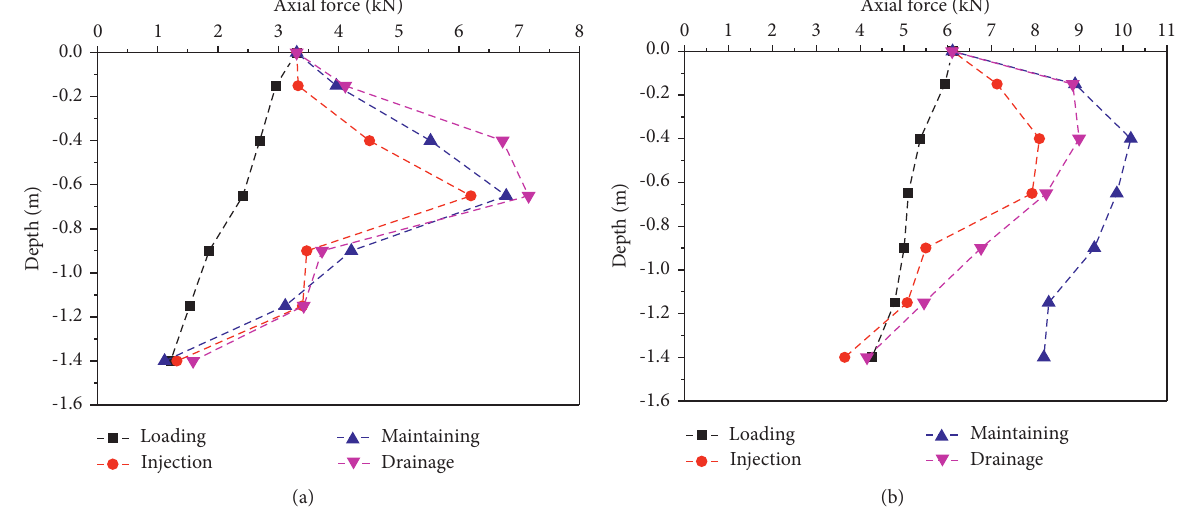
Figure 6: Typical axial force distribution of piles in different test conditions. (a) Pile load: 12kN. (b) Pile load: 24kN.